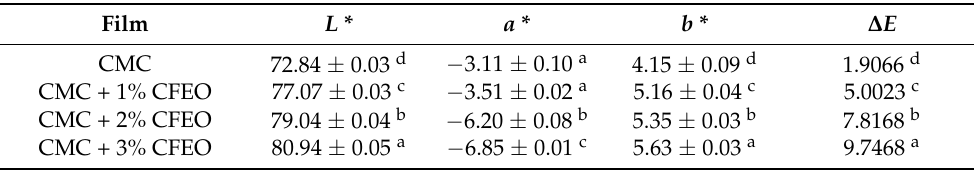
Table 3. Color values of CMC and blended CMC-CFEO